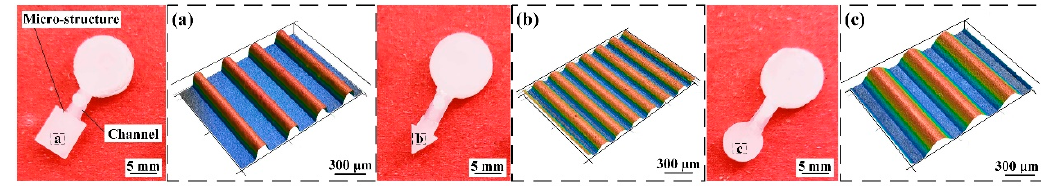
Figure 2. Micro-structured parts and surface morphology: ( a ) U-shaped; ( b ) semi-circular; ( c ) V- shaped.